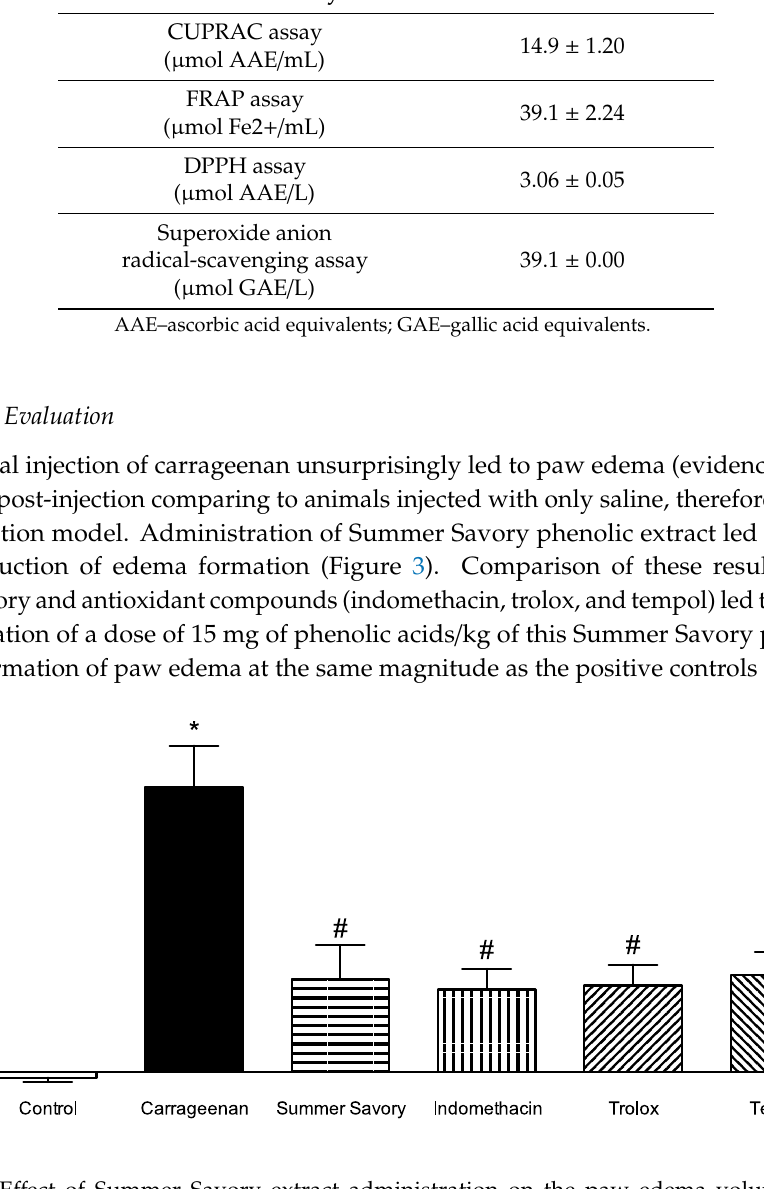
Table 3. Antioxidant capacity test results.